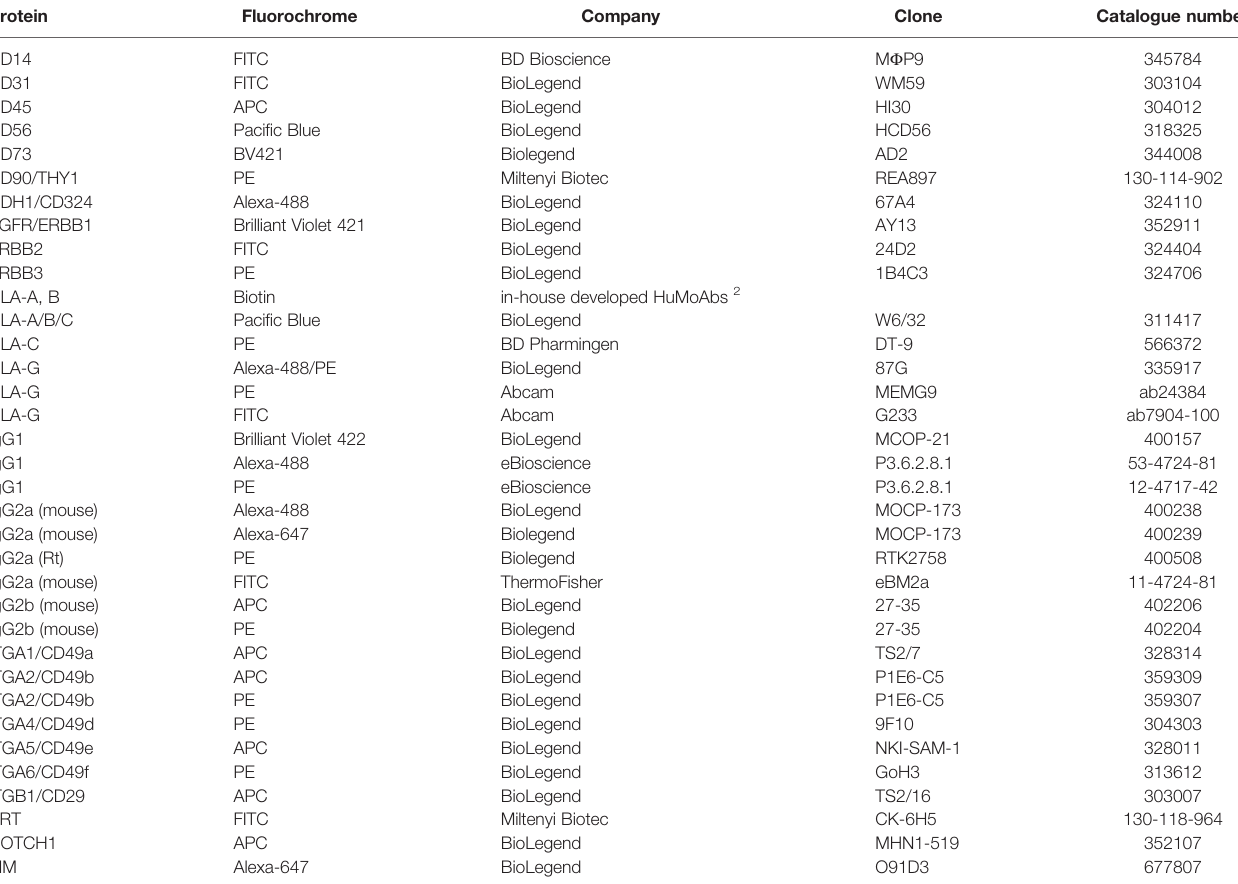
TABLE 2 | Overview of antibodies used for fl ow cytometry in the study 1 . Protein